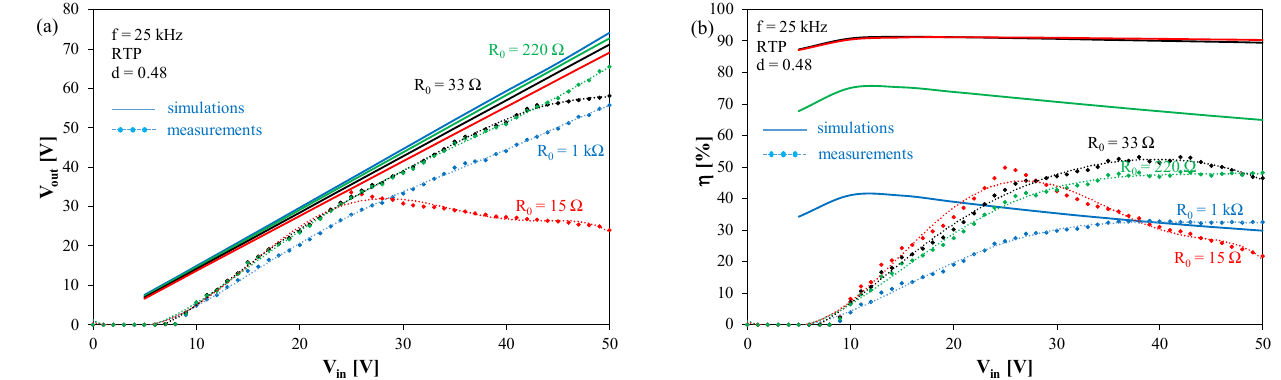
Figure 9. Measured and computed simulated with the model of an ideal transformer dependences of the output voltage ( a ) and energy efficiency ( b ) of the tested DC-DC converter on its input voltage at f = 25 kHz.